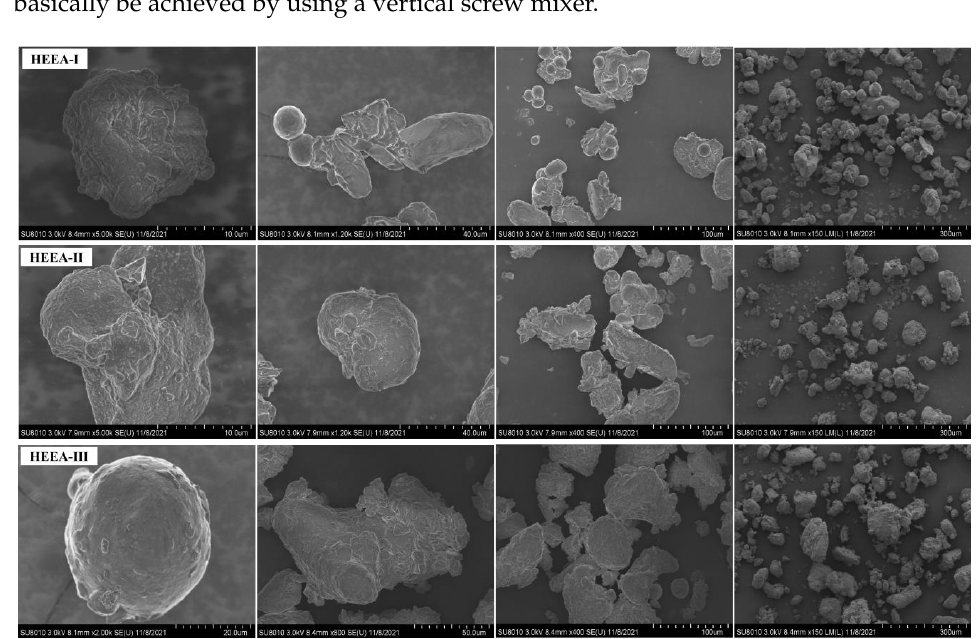
Figure 7. FE-SEM characterization of high-energy expansion